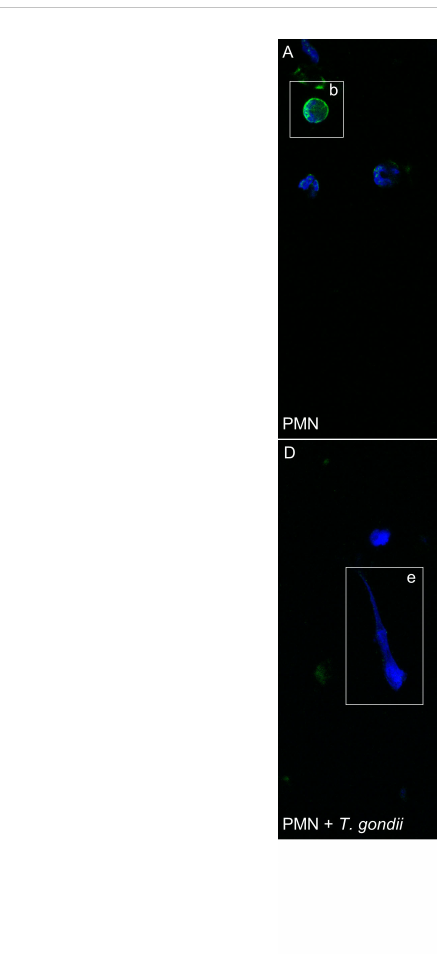
FIGURE 5 T. gondii induces relocation of lamin B1 in bovine stimulated PMN. 2 × 10 5 bovine PMN were confronted with vital 4 × 10 5 T. gondii tachyzoites (1:2 ratio) for 60 min. Samples were fi xed in PFA 4% and the specimens were stained for lamin B1 (green channel) and DNA (blue channel; DAPI). Unstimulated PMN (A) shows a perinuclear distribution of lamin B1 (B, C) . T. gondii -confronted PMN (D) show in contrast, a loss of continuous perinuclear lamin B1 signals when forming NETs (E) or relocation when the chromatin is decondensed (F) . Images are representative of 3 (n=3) individual